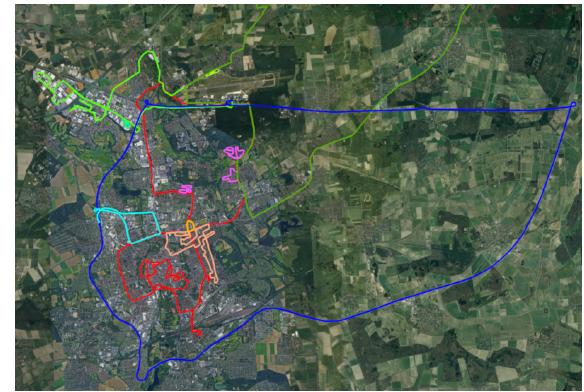
Figure 2. Planned routes of the reference car in and around Brunswick/Germany; blue: motorway, dark green: rural roads, bright green: industrial area, red: city area, orange/magenta: suburbs (from GoogleEarth)